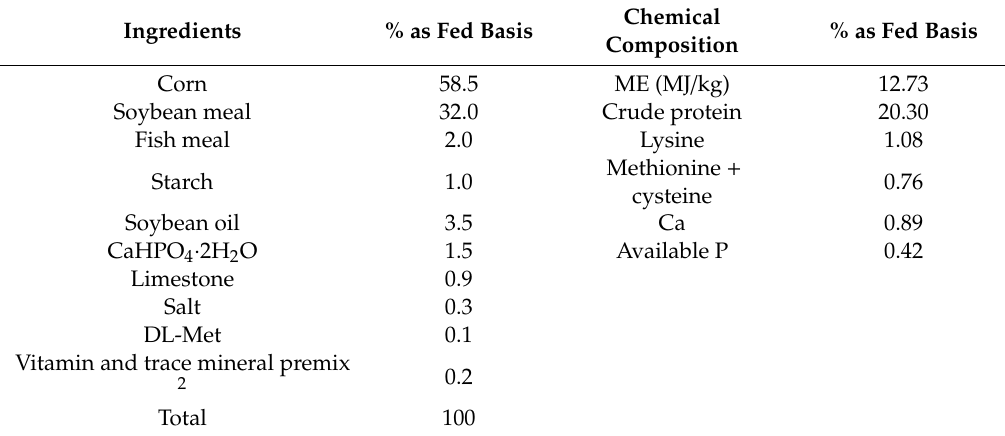
Table 1. Composition of the basal diet 1